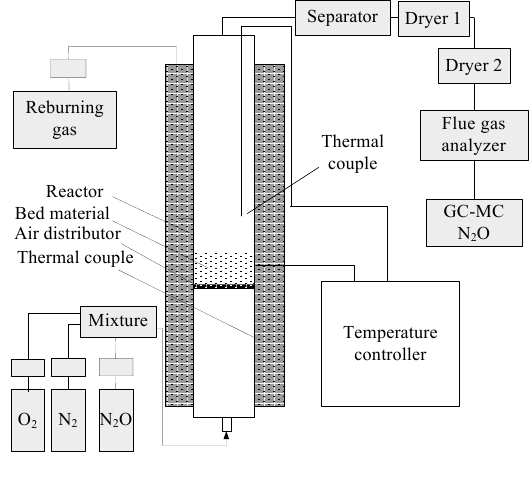
Figure 1. Schematic of the lab-scale quartz fluidized bed